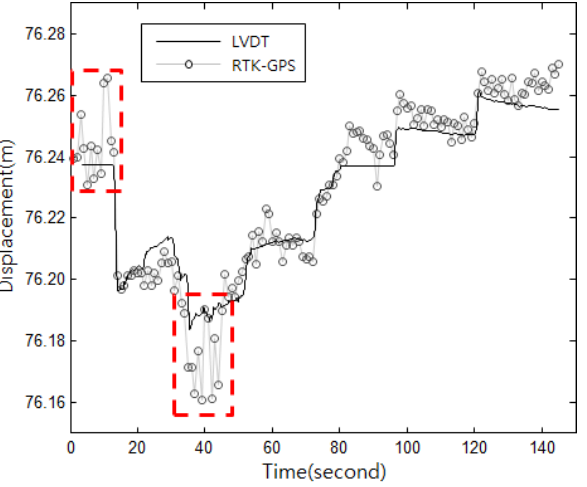
Figure 13. Example of the experiment result for assessing the accuracy of the vertical displacements measured from RTK-GPS, with the distribution of the RTK-GPS measurements with the LVDT values as reference. The dashed rectangles indicate excessive errors.